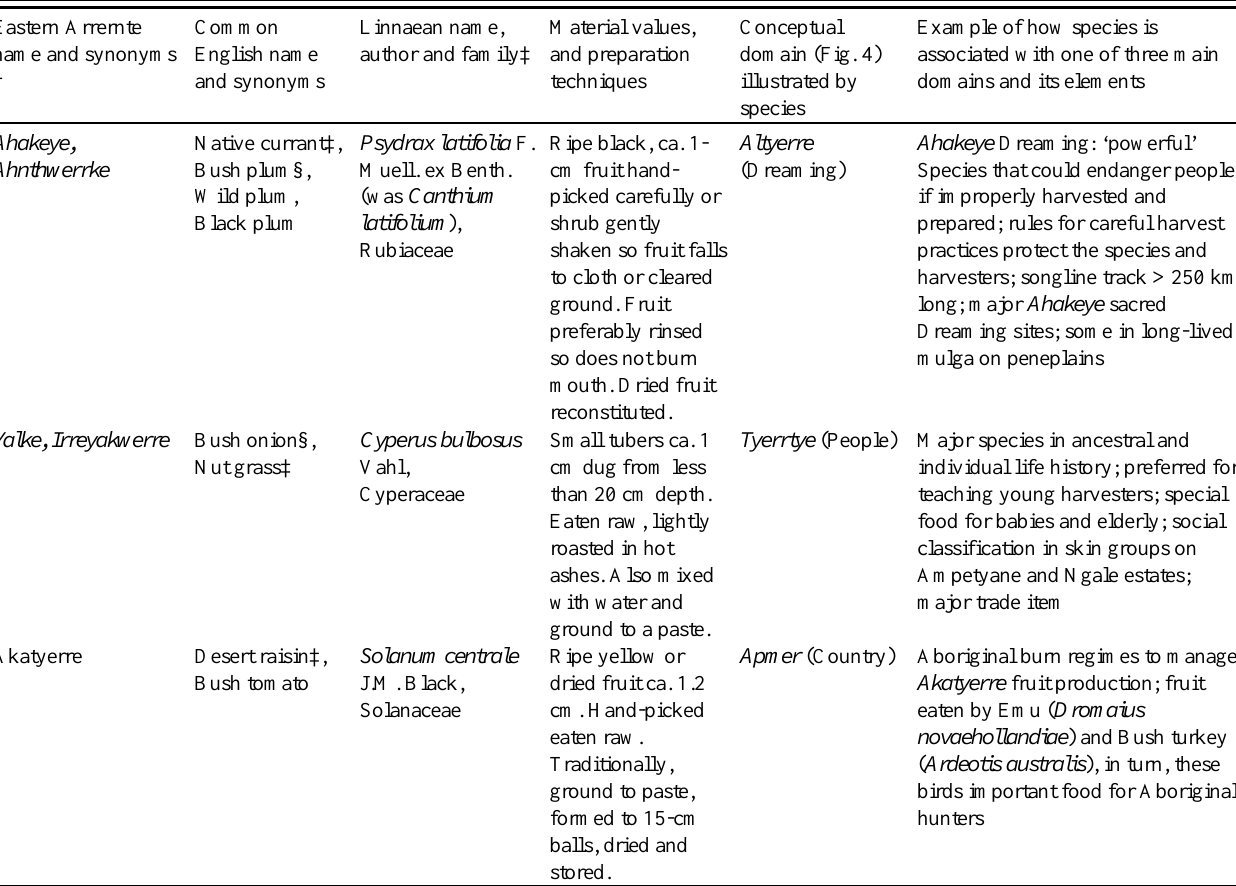
Table 1. Arrernte, English, and scientific names and synonyms for the species and the domain illustrated by each species, with example of related elements or values. Figure 8 illustrates these